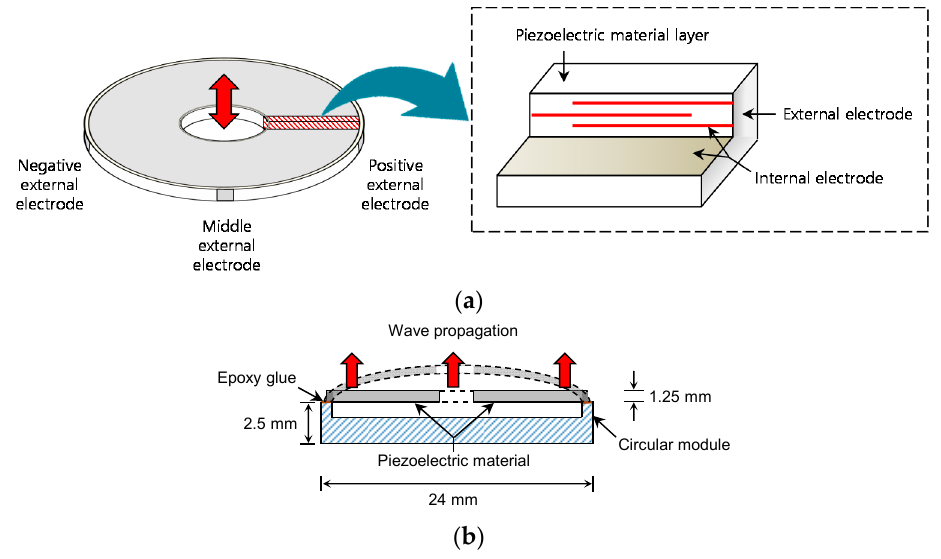
Figure 1. Schematic of ring bender: ( a ) shape and components; ( b ) installation.